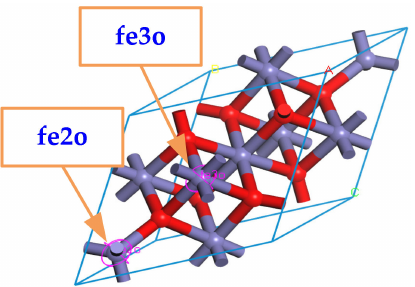
Figure 2. Multiple forcefield types for Fe atoms in Fe 3 O 4